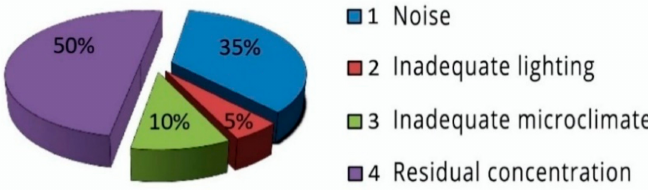
Figure 1. Influence of environmental requirements on concentration. Figure re-edited from